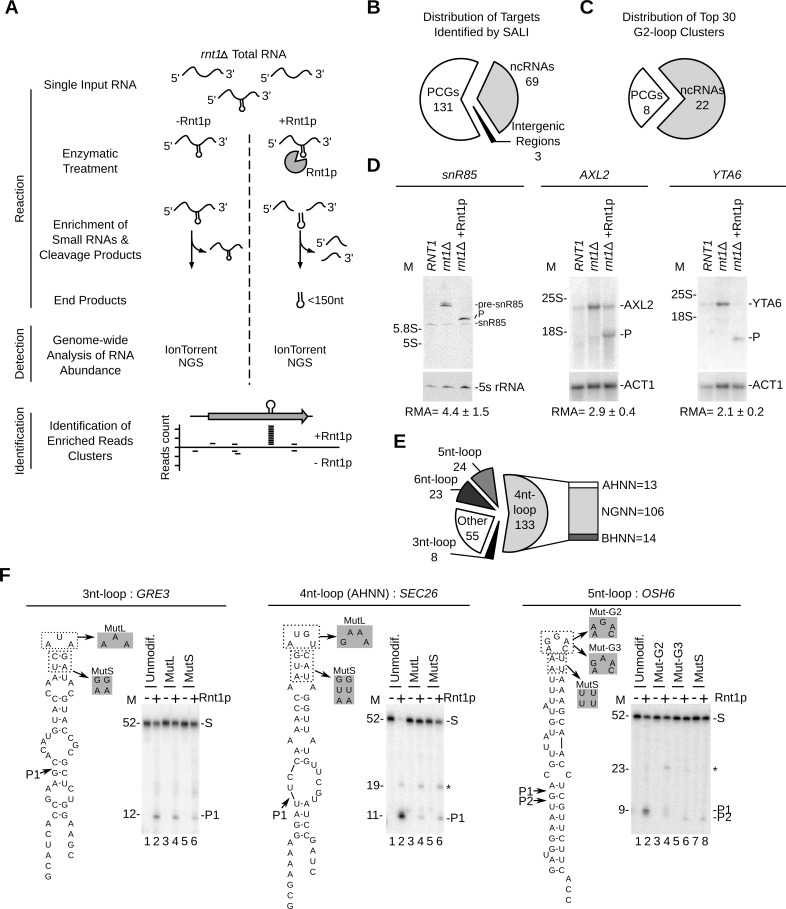
Sequence assisted identification of Rnt1p cleavage signals.(A) Strategy for Sequencing Assisted Loop Identification (SALI). In this strategy, rnt1∆ RNA is cleaved by Rnt1p, RNA fragments < 150 nucleotides enriched and the 32–38 nucleotides internal cleavage fragments identified using next generation sequencing (NGS) (S5 Fig.). (B) Pie chart illustrating the types of RNAs associated with at least one enriched read cluster (details in S15 Table). (C) Distribution of the top 30 enriched read clusters by RNA type (details in S16 Table). (D) Cleavage of new substrates was verified using Northern blot as described in Fig. 1G. ACT1 mRNA and 5S rRNA were included as negative controls. The relative RNA expression (RMA) was calculated as described in Fig. 1G. (E) SALI uncovers new classes of Rnt1p substrates. The cleavages products identified by SALI were folded and the resulting structures shown in the form of pie chart. Unfolded RNAs and stems capped with loops larger than 6 nucleotides were classified as “other”. The loop sequence is described using standard single letter nucleotide code (IUPAC). (F) Validation of the new classes of Rnt1p substrates. A representative member of each loop type (unmodif) as well as mutated loop (MutL) and stem (MutS) versions were transcribed and cleaved by Rnt1p. The cleavage products were identified using 20% denaturating PAGE (see also S5E Fig.). Substrate (S) and products (P) are indicated on the right. The size markers are indicated on the left. The observed cleavage sites are indicated by arrowheads.